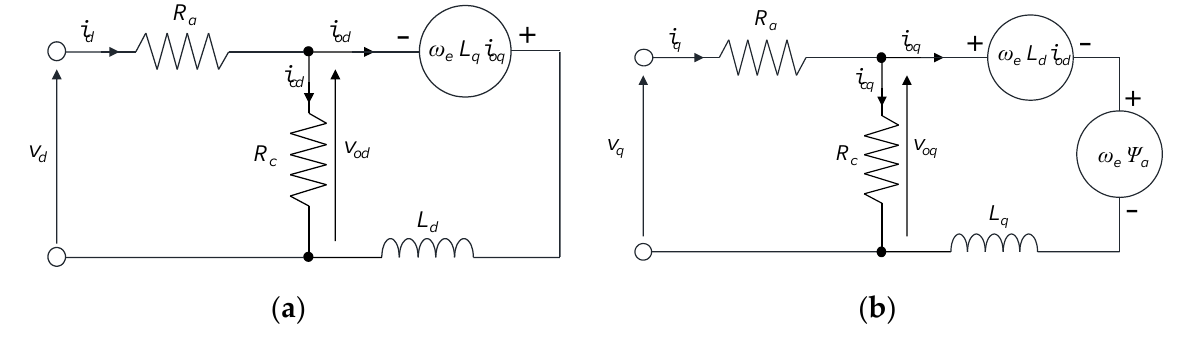
Figure 6. Equivalent circuit: ( a ) d-axis and ( b ) q-axis [14]. The meanings of the symbols expressed in Equations (10)–(13) are as